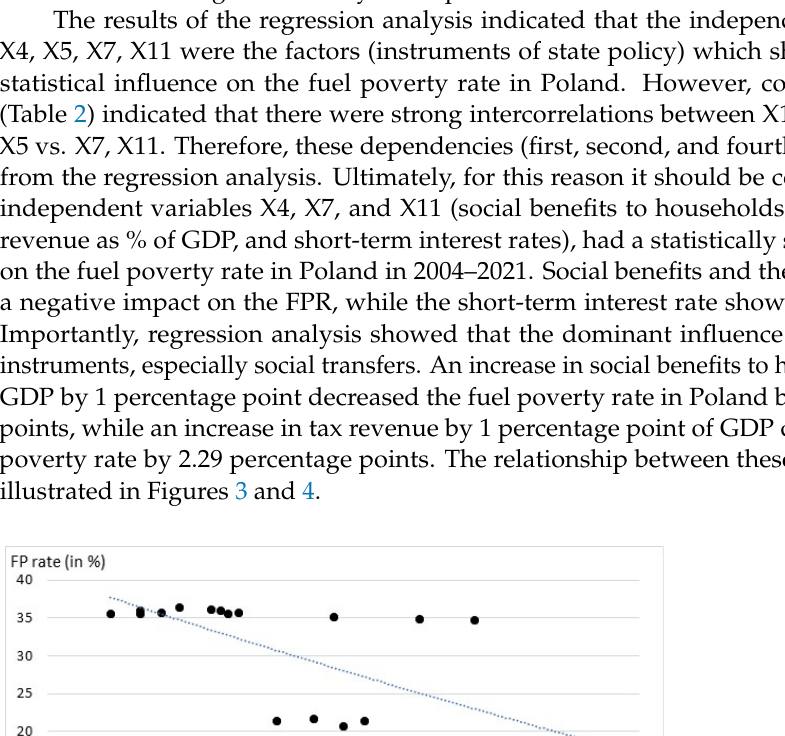
Figure 4. Relationship between fuel poverty rate and tax revenue in Poland in 2004–mid ‐ 2021. Interesting findings concern the impact of tax burdens. Their impact on fuel poverty is negative (Figure 4). The occurrence of such a relationship should be associated with the fact that the higher the tax revenue in relation to GDP, the more resources the government has that can be allocated to social benefits to households. The results of the regression analysis indicated that the short ‐ term interest rates also have a statistically significant impact on the fuel poverty rate. This dependence is positive (Figure 5). Short ‐ term interest rates are an instrument of monetary policy in Poland which,